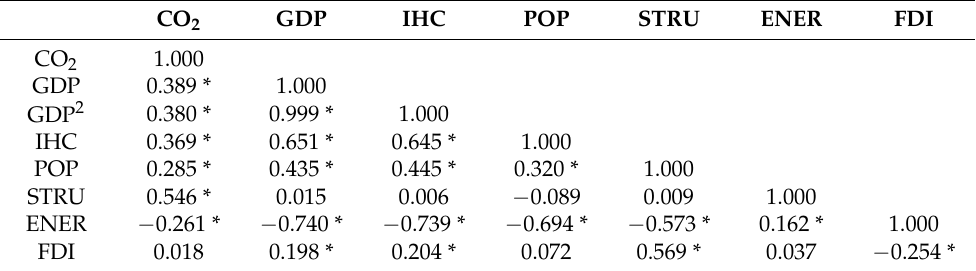
Table 5. Pairwise correlations.